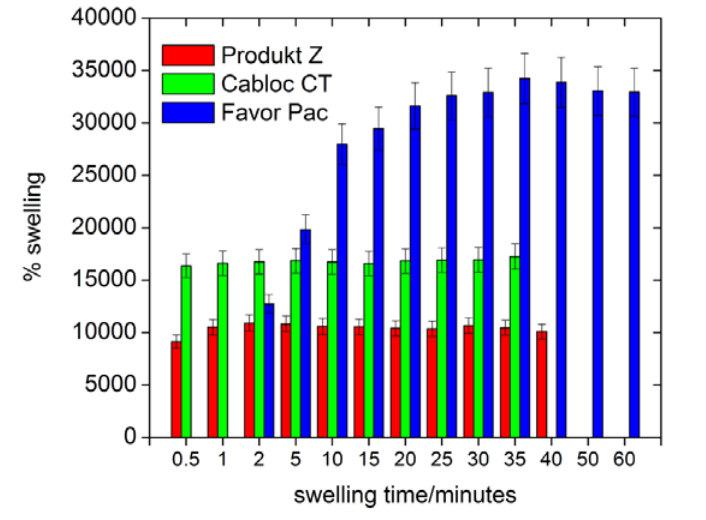
Figure 4 . Swelling of the polymers in deionized water vs. time.